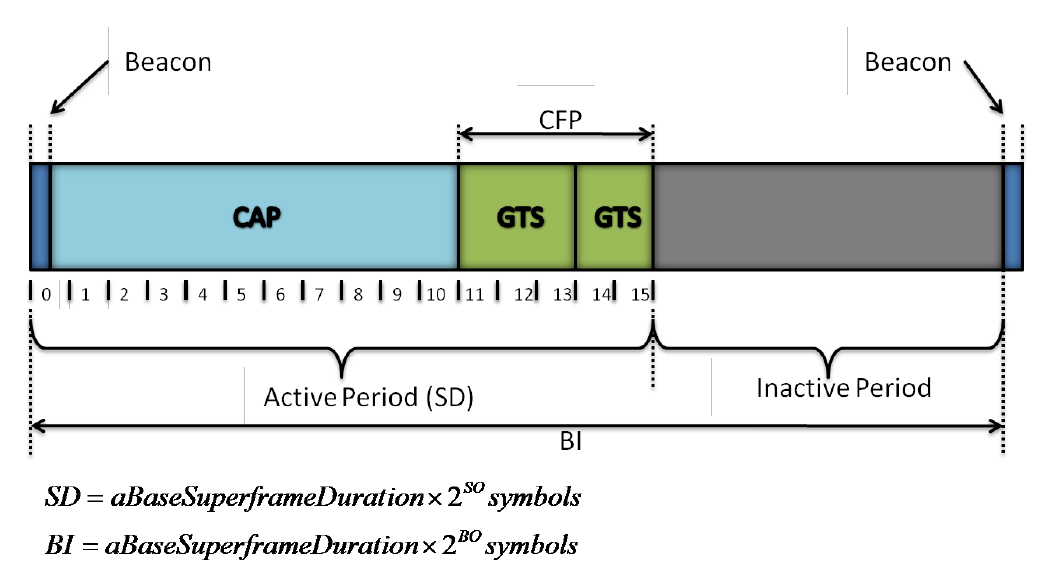
Figure 2. Example of the superframe structure of IEEE